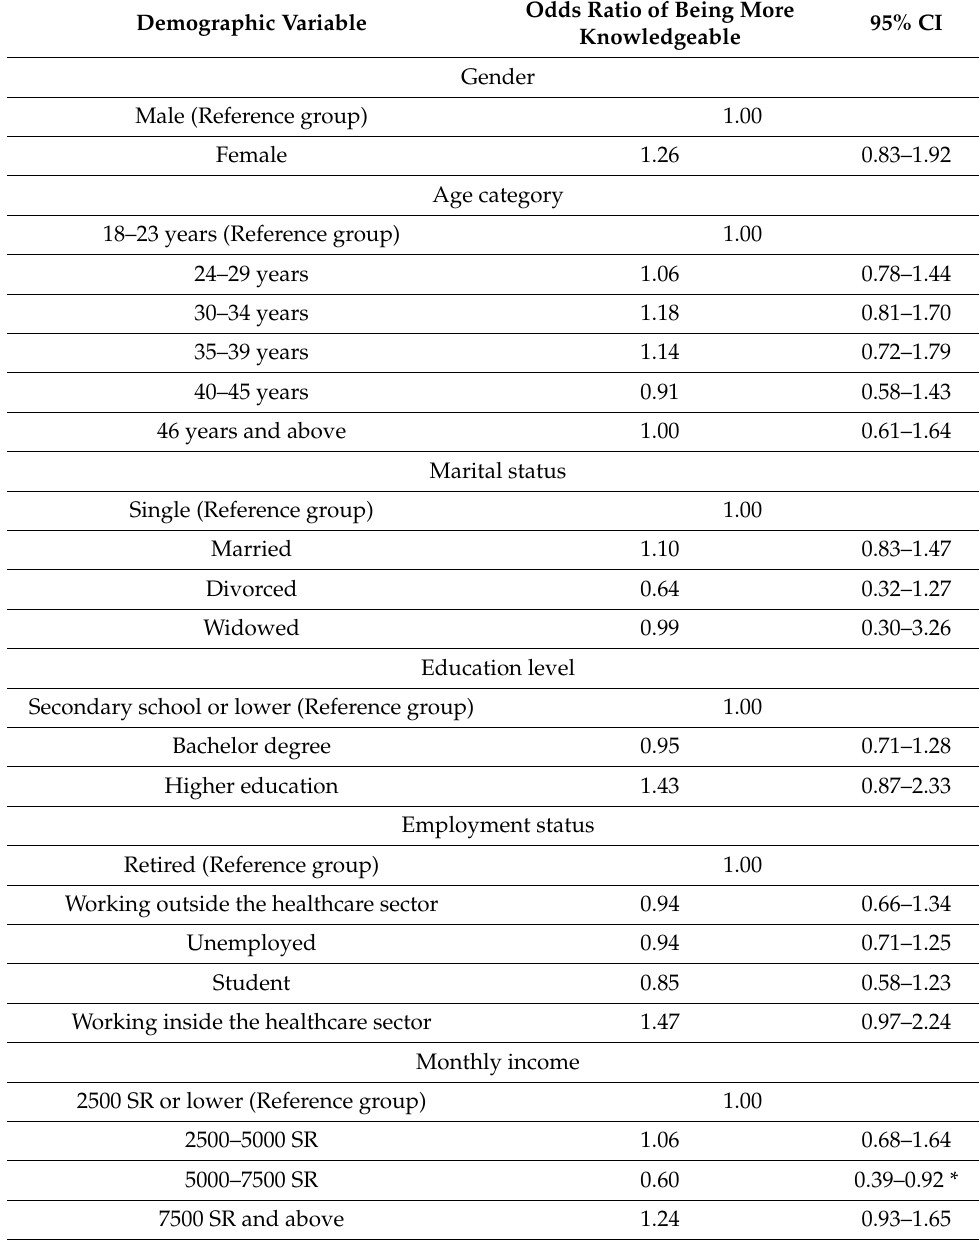
Table 3. Binary logistic regression